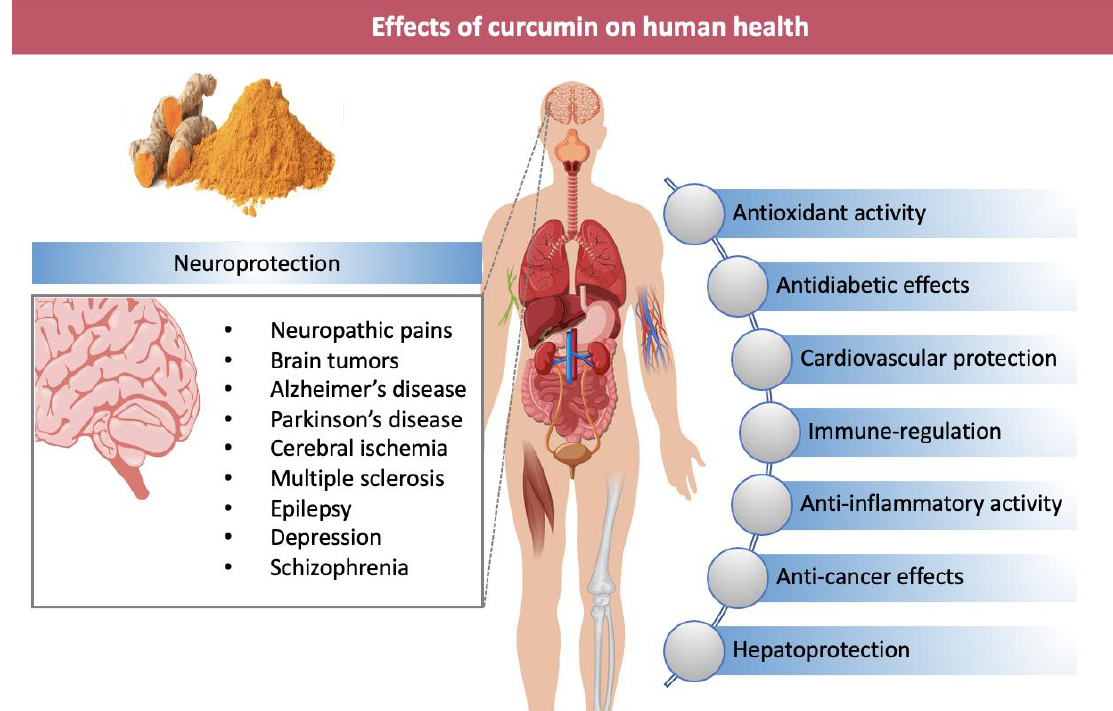
Figure 1. Biological activities of curcumin and related benefits on health. Curcumin finds application in management of central nervous system pathologies (neurodegenerative disorders, brain cancer and health mental illness).